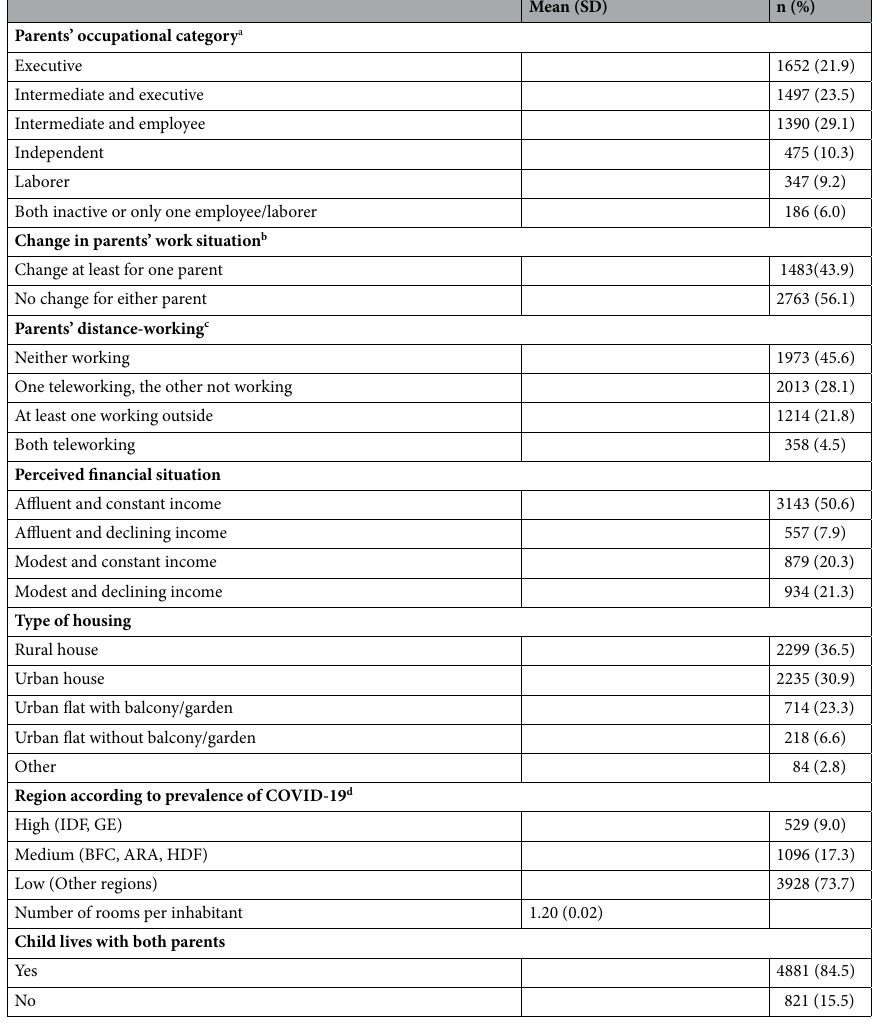
Table 2. Socioeconomic characteristics of children’s families in SAPRIS project in France on weighted data (n = 5702). a In the absence of a spouse, the respondent who is executive refers to «intermediate and executive» category; which is intermediate corresponds to «intermediate and employee» category; and which is employee, worker or without profession refers to «both inactive or only one employee/labourer» category. b In the absence of a spouse, the respondent who has undergone a change in work situation during the lockdown refers to «change at least for one parent» category and the one who has not undergone any change to «no change for either parent» category. c In the absence of a spouse, the respondent who is not working is associated with the «neither working» category; the one who teleworks refers to «both teleworking» category; and the respondent who works outside to «at least one working outside» category. d Region classified according to the prevalence of COVID-19 at the beginning of the epidemic (High: Ile de France and Grand Est vs Medium: Bourgogne- Franche-Comté, Auvergne-Rhône-Alpes and Hauts-de-France vs Low: other